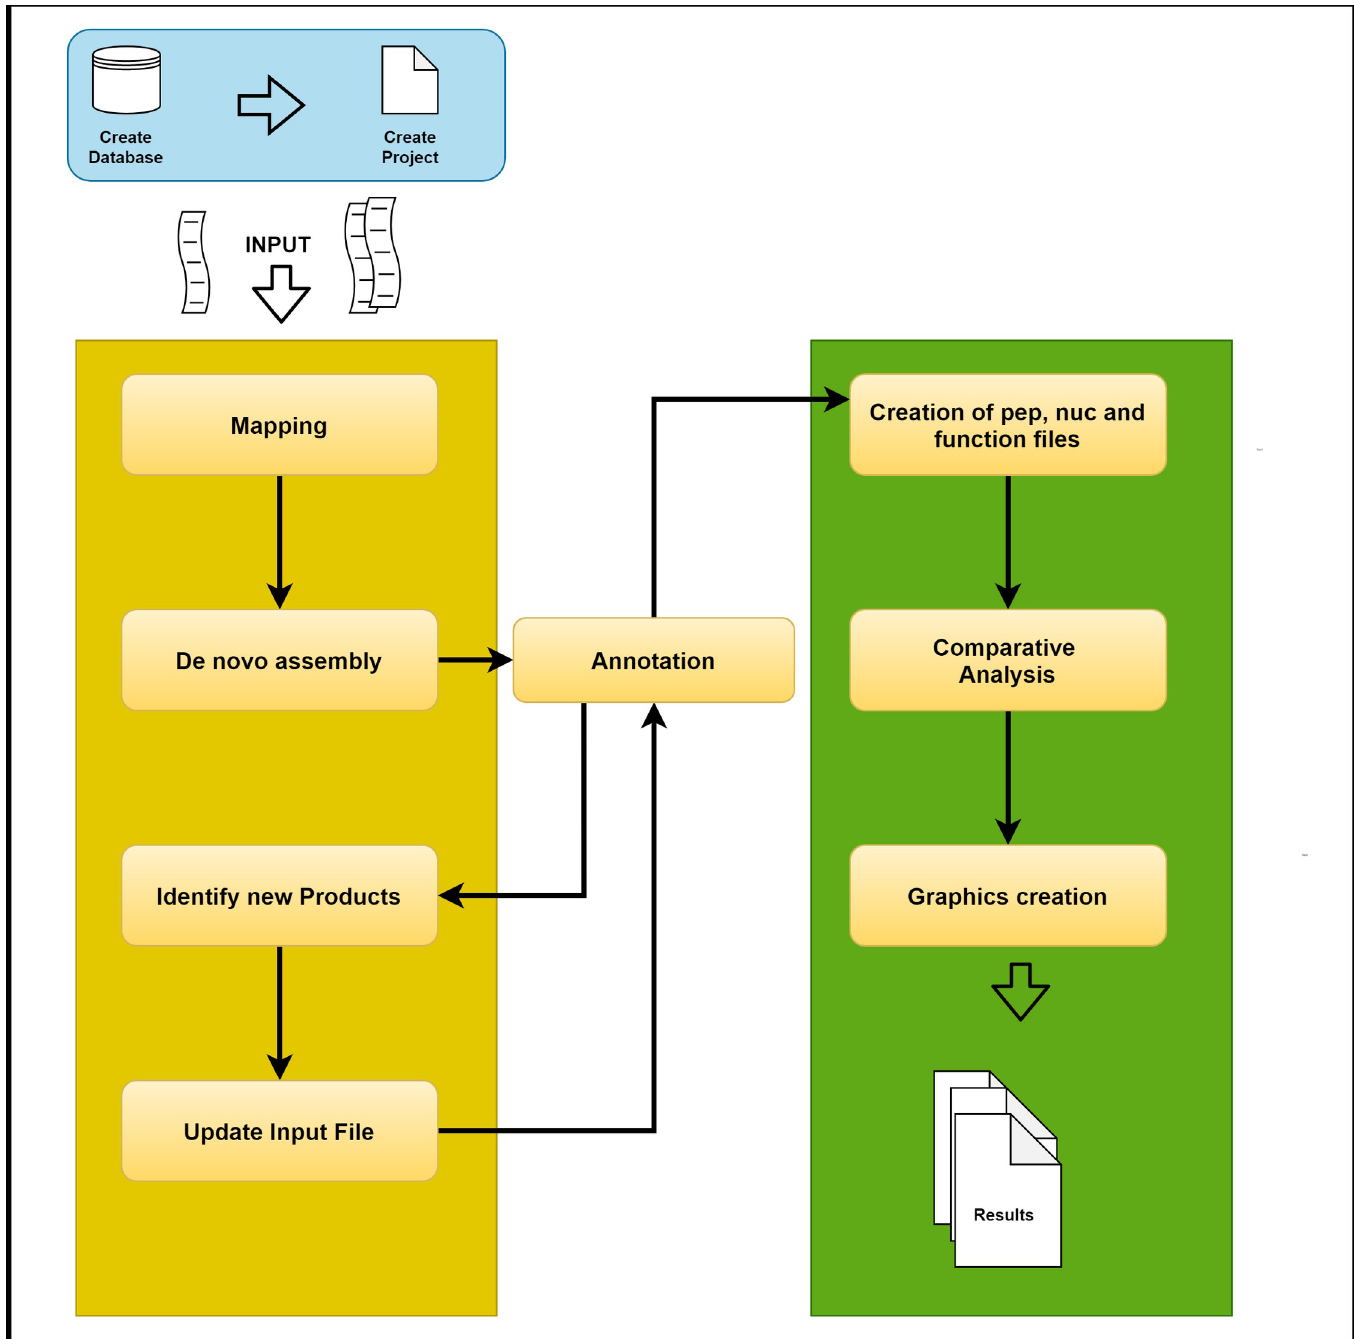
Fig 1. PAN2HGENE pipeline. Identification of gene products missing from the original sequence is shown in yellow and the process of comparative analysis is shown in green.